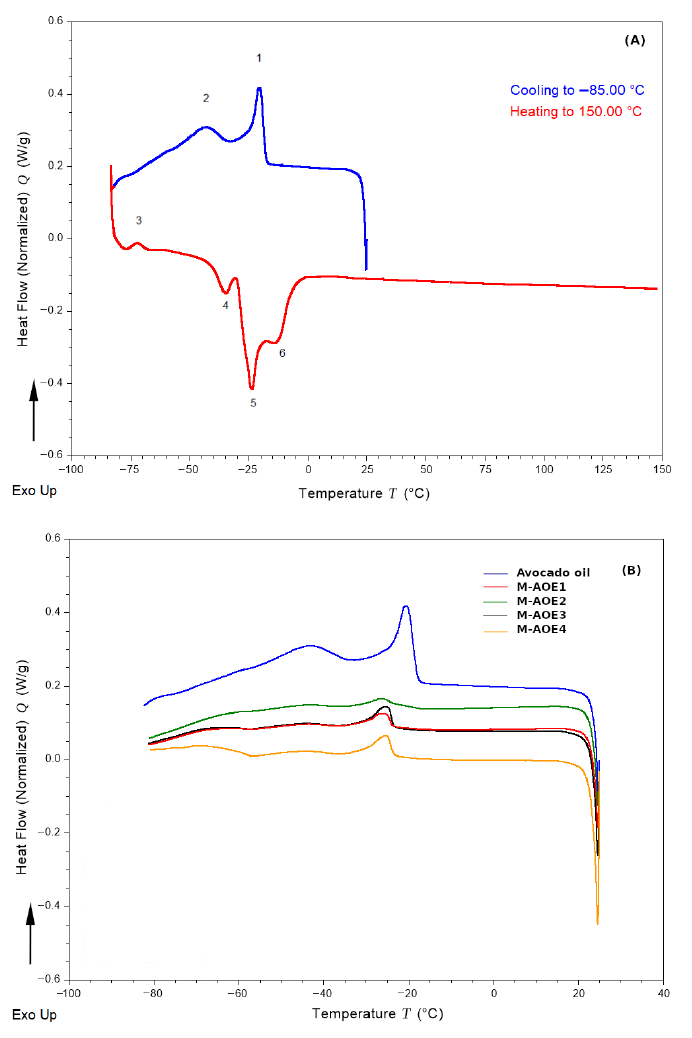
Figure 5. DSC thermogram of avocado oil ( A ) and avocado oil microcapsules after spray drying ( B ). DSC analysis is sensitive to phase transitions of edible oils present in food